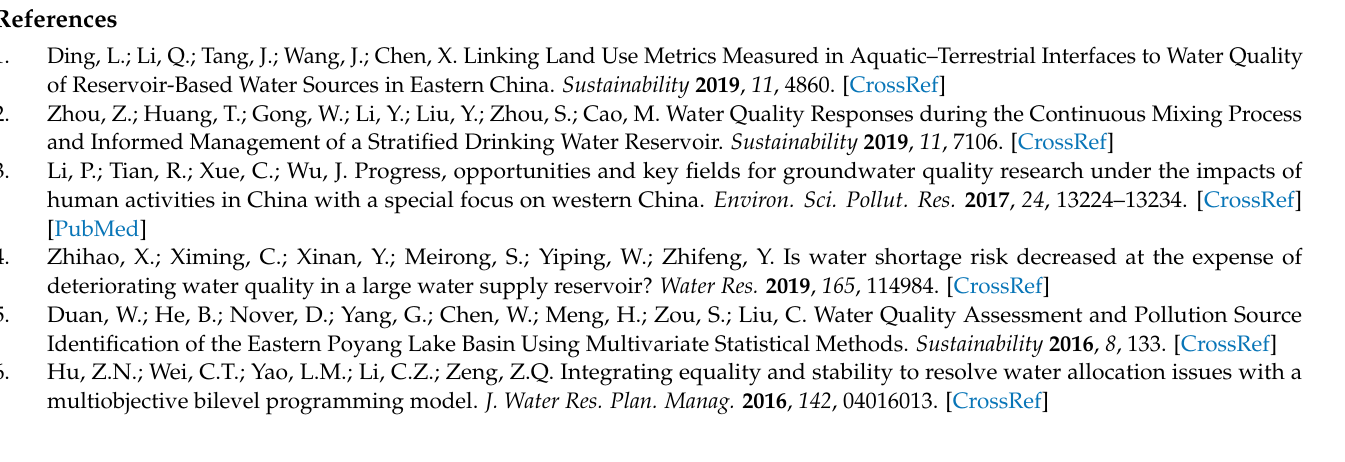
Table S2: Reference range for water quality parameters for RTWQI calculation; Table S3: Descriptive statistics of the RTWQI; Table S4: Mean values of physicochemical and biological parameters in different seasons in the PDR; Table S5: Results of principal component analysis of normalized data: total variance